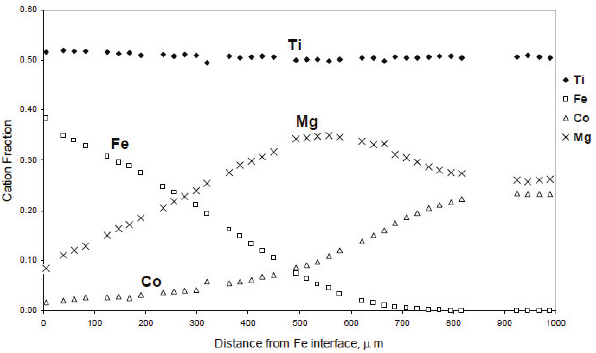
Figure 4. Composition profiles of the titanate solid solution formed by reaction of Fe with (Co 0:48 Mg 0:52 / TiO 3 after 360 ks at 1273